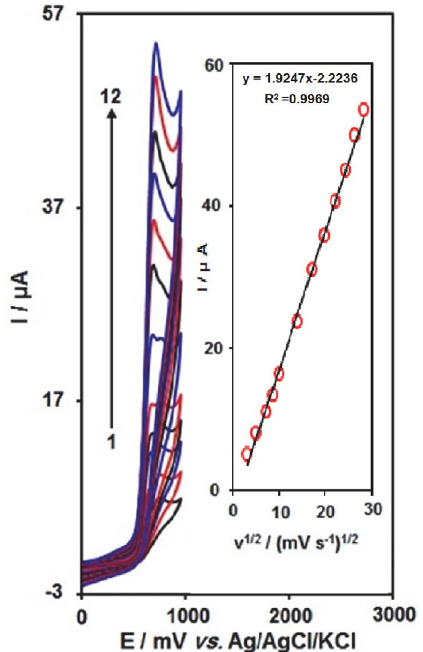
Fig. 5. CVs of NFO/SPE in 0.1 M PBS (pH 7.0) containing 150.0 µM of folic acid at various scan rates; numbers 1–12 correspond to 10, 25, 50, 75, 100, 200, 300, 400, 500, 600, 700 and 800 mV s – 1 , respectively. Inset: Variation of anodic peak current vs . square root of scan